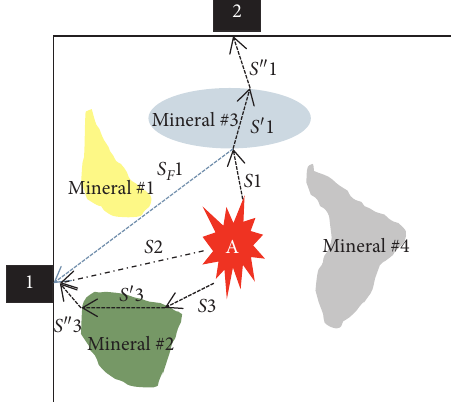
Figure 2: Schematic diagram of the influence of heterogeneity on AE signal propagation.